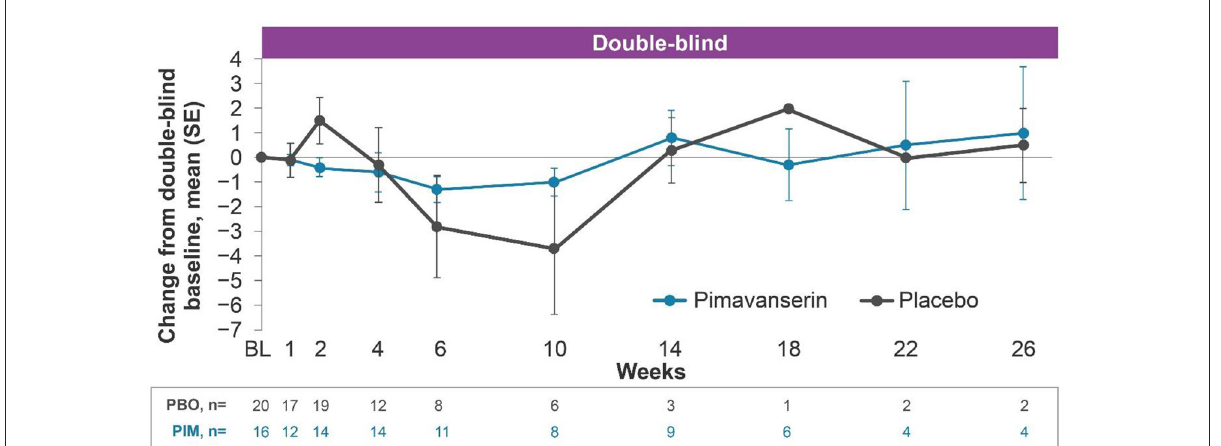
FIGURE2 Change from baseline ESRS-A total score, HARMONY PD dementia with psychosis (pimavanserin 34mg) subgroup. PD dementia with psychosis pimavanserin 34-mg subgroup as of study end date data cutoff of Oct, 30 2019. BL, baseline; ESRS-A, Extrapyramidal Symptom Rating Scale-Abbreviated; PBO, placebo; PD, Parkinson’s disease; PIM, pimavanserin; SE, standard error.